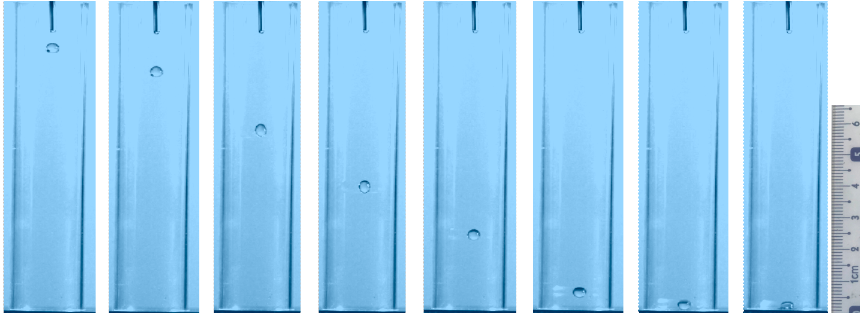
Figure 5. Deformation shape of free-falling water droplet in test at 283.15 K.